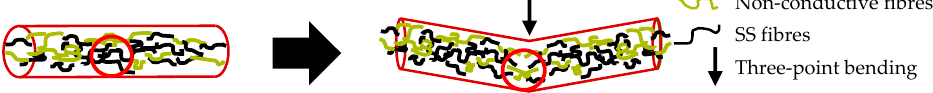
Figure 7. Morphology of the conductive yarns with the cracking process: separation of the SS fibres inside the spun yarn.